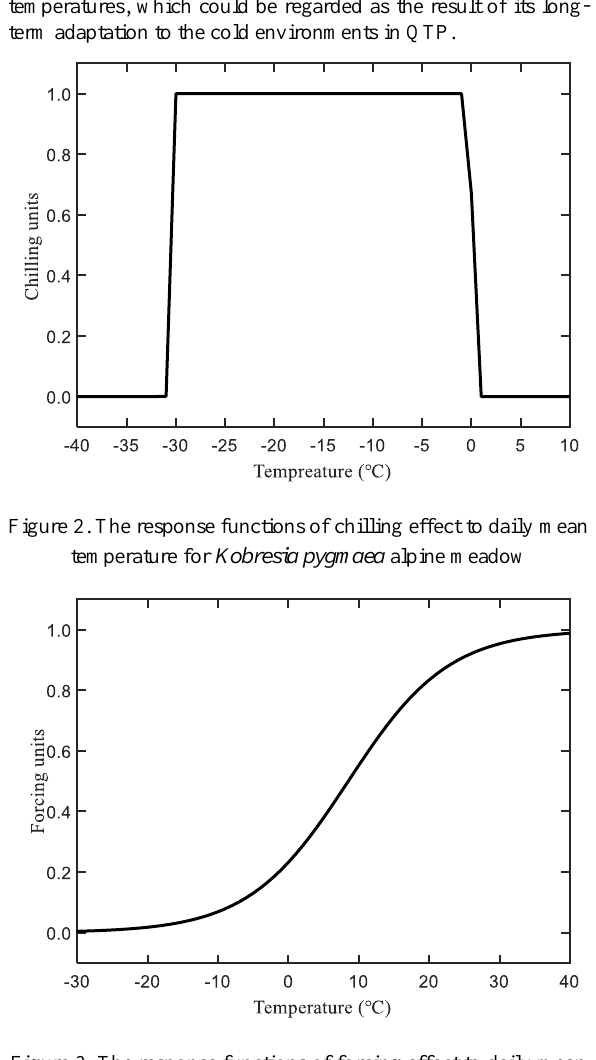
Figure 3. The response functions of forcing effect to daily mean temperature for Kobresia pygmaea alpine meadow